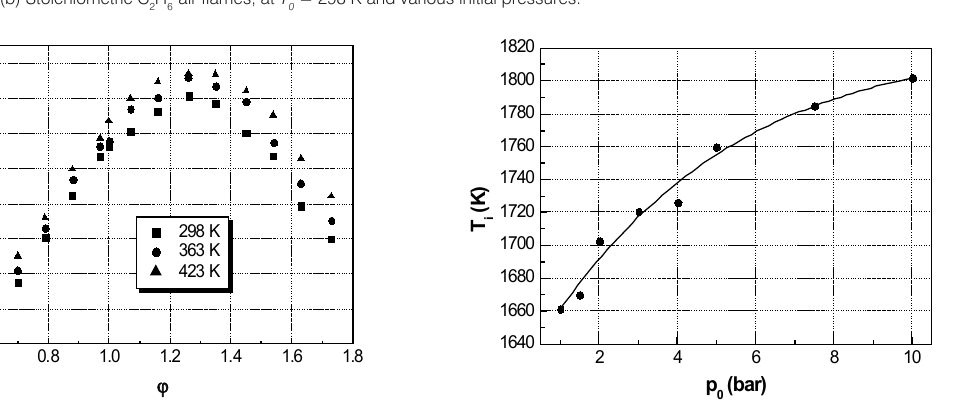
H -air mixtures. (a) Rich C 2 6